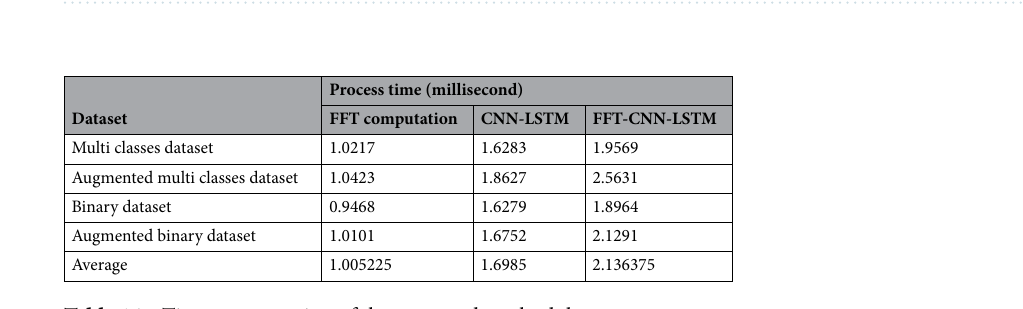
Table 13. Comparison between related work and the proposed method using PhysioNet/CinC 2016 challenge dataset.